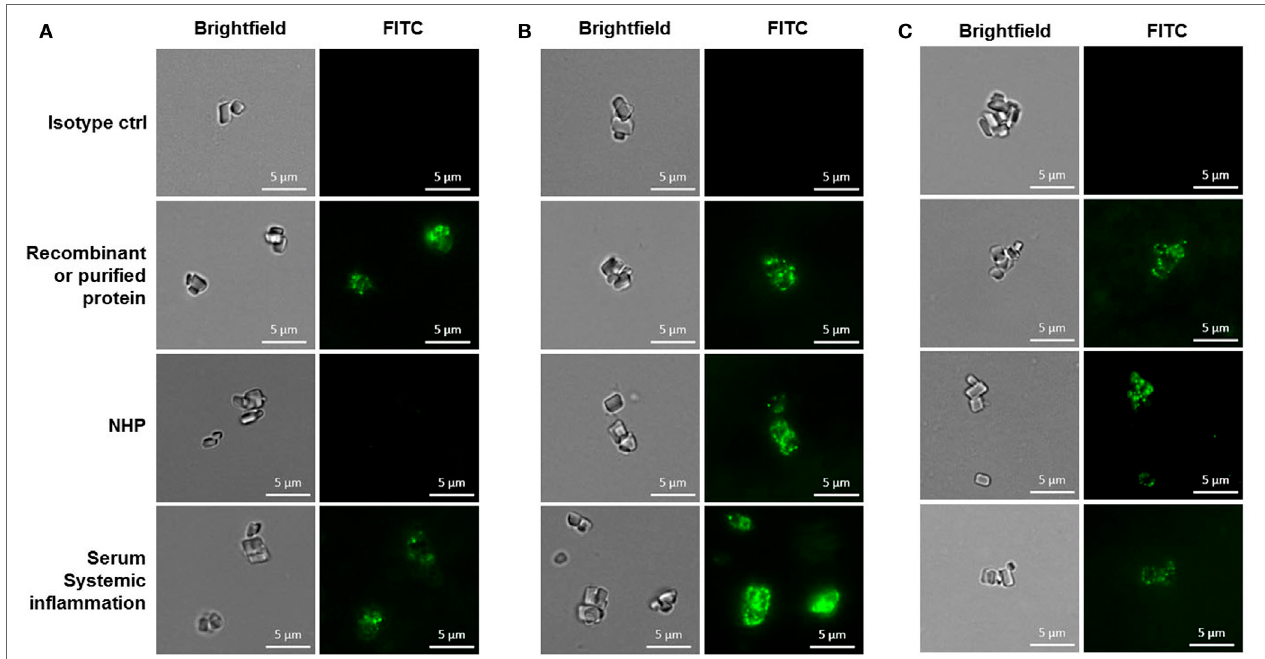
FigUre 2 | Binding of pentraxin 3 (a) , C-reactive protein (B) , or SAP (c) to cholesterol crystals assessed by fluorescence microscopy. Imaging conditions were kept constant when acquiring images to be compared. Results are representative of three independent experiments. NHP, normal human